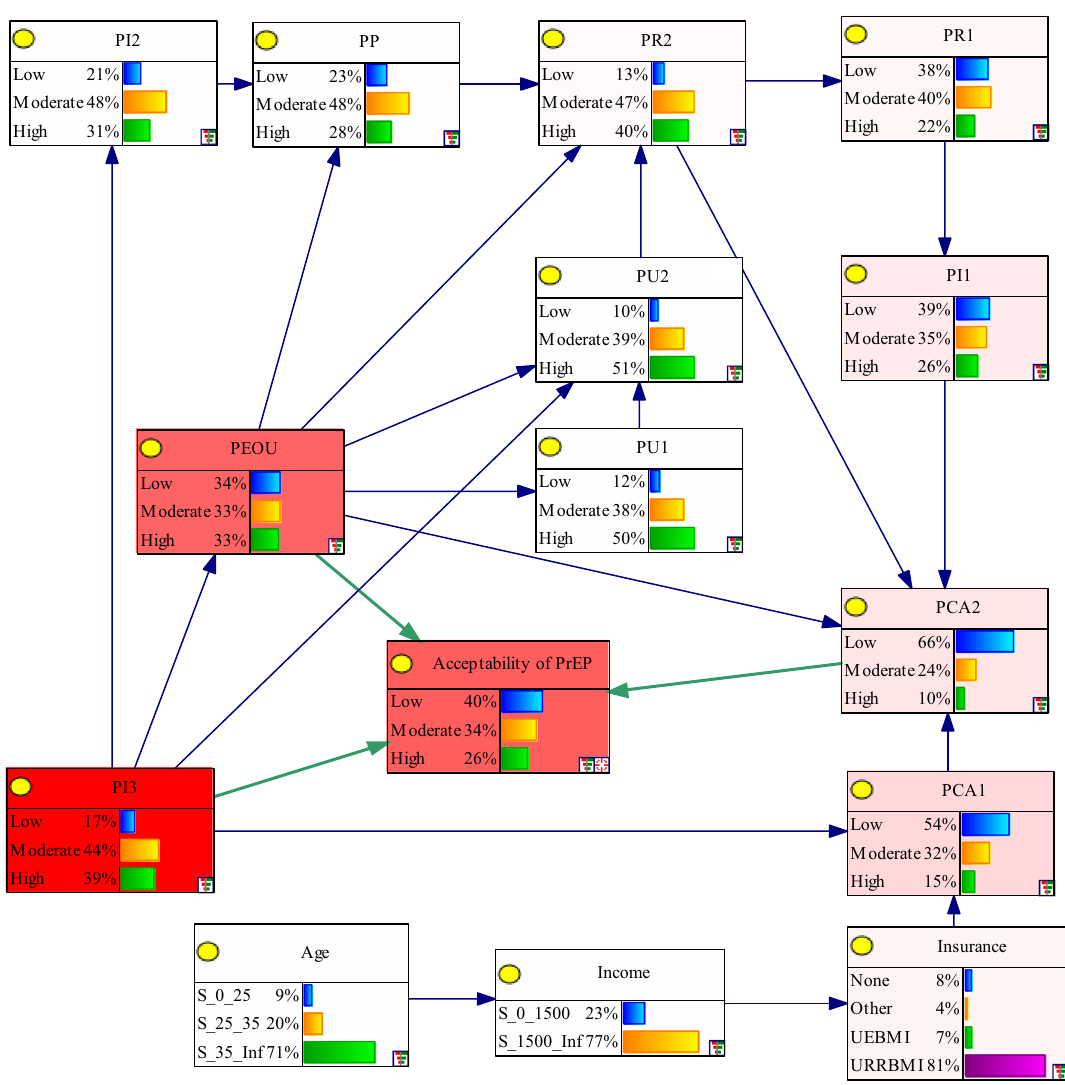
Figure 1. Marginal probability distribution for the Bayesian network association of acceptability of PrEP. The figure was plotted by GeNIe (3.0). PI2 perceived image of user as public-minded, PP perceived privacy problem, PR2 perceived risk of side-effects, PR1 perceived risk of PrEP in increasing risk behavior, PU2 perceived utility of PrEP in reminding health awareness, PI1 perceived image of user as having sexual risky behavior, PEOU perceived ease of use, PU1 perceived utility of facilitating prevention of HIV, PCA2 perceived comparative advantage of having sex when the urge arises, PCA1 perceived comparative advantage over condom use, PI3 perceived image of user as health-conscious, PrEP Pre-exposure